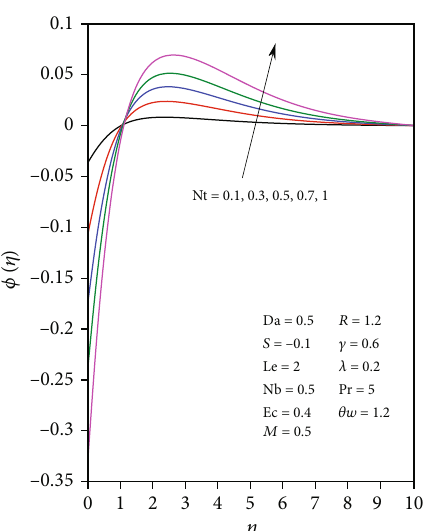
Figure 21: Concentration of nanoparticle pro fi le for di ff erent values of γ .